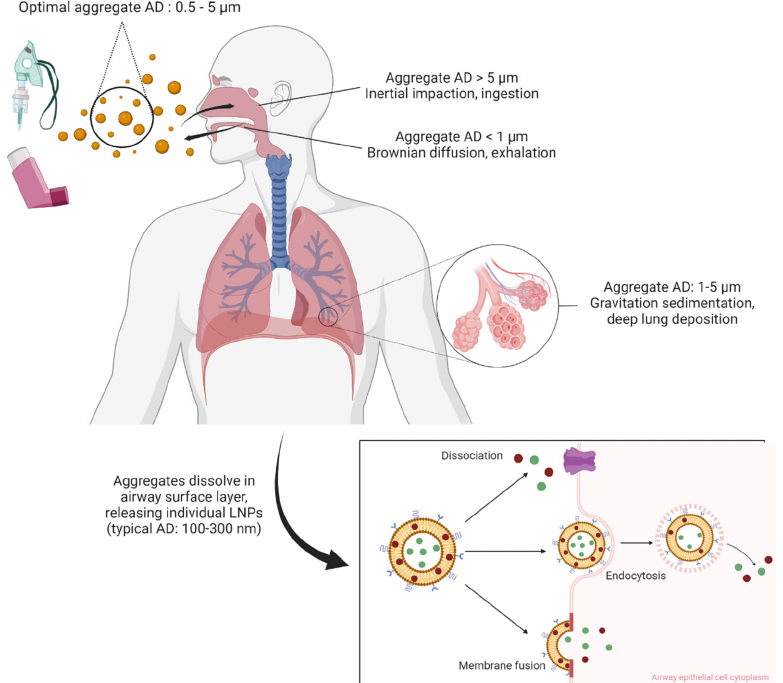
Figure 3. Schematic summary of AD-dependent deposition and distribution mechanisms of inhaled LNP aggregates in the airways. The mechanisms are inertial impaction, gravitation sedimentation and Brownian diffusion. Subsequent cellular uptake of individual LNPs and drug payloads by dissociation, endocytosis and membrane fusion facilitate therapeutic action (PEGylated and targeted liposome depicted). AD: aerodynamic diameter. Created with BioRender.com.